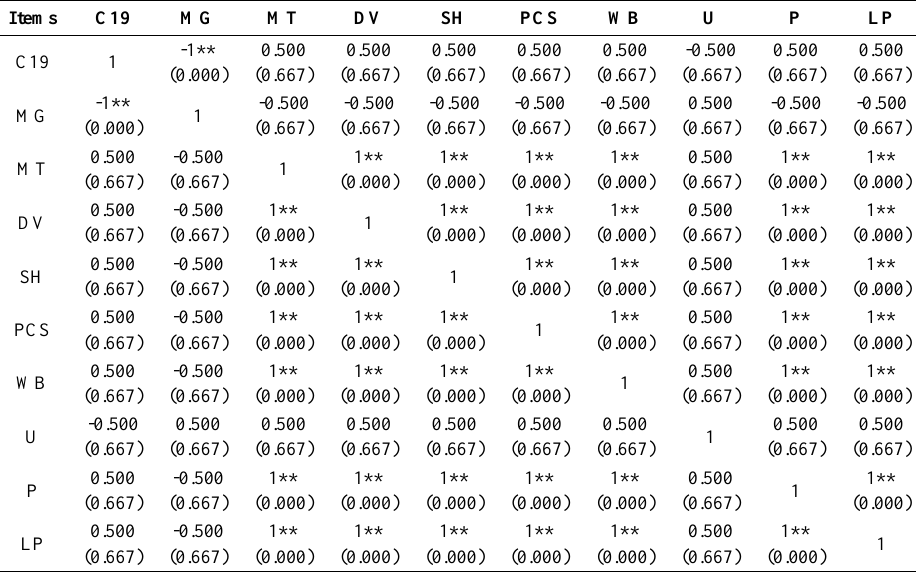
Table 5. Summary of Spearman's Rho correlation (**p